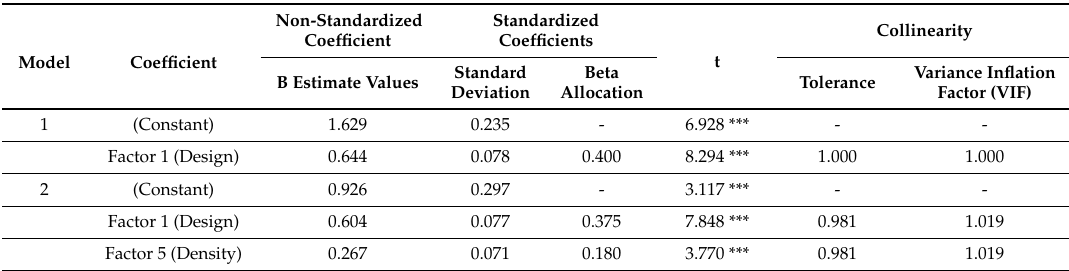
Table 5. The regression coefficient table for TOD living environment characteristics and living environment